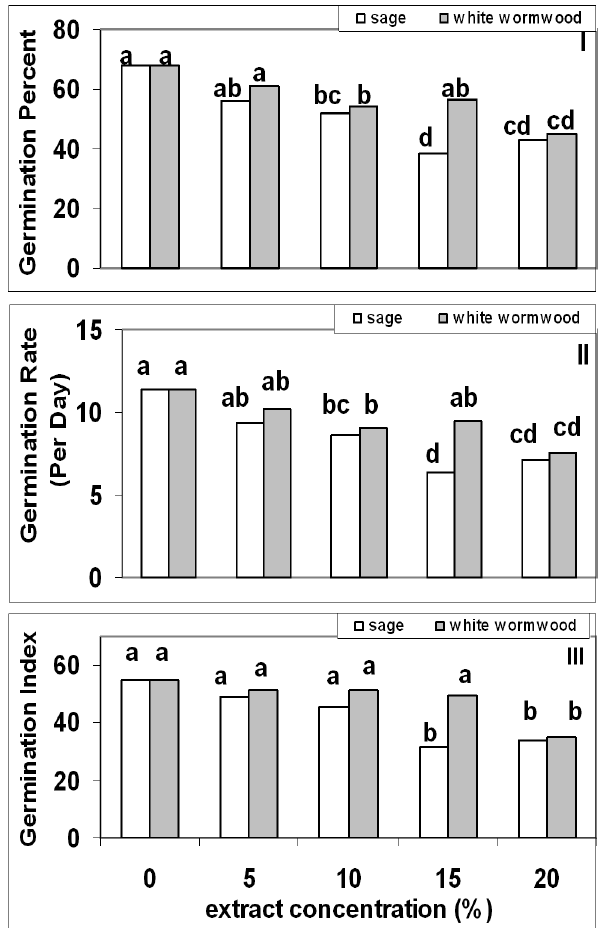
Fig. 1. Means comparisons of interaction effects between extract origin (sage and white wormwood) and concentration on ger- mination percent (I), rate (II) and index (III) of Portulaca olera- cea seeds. The same letters show non significant